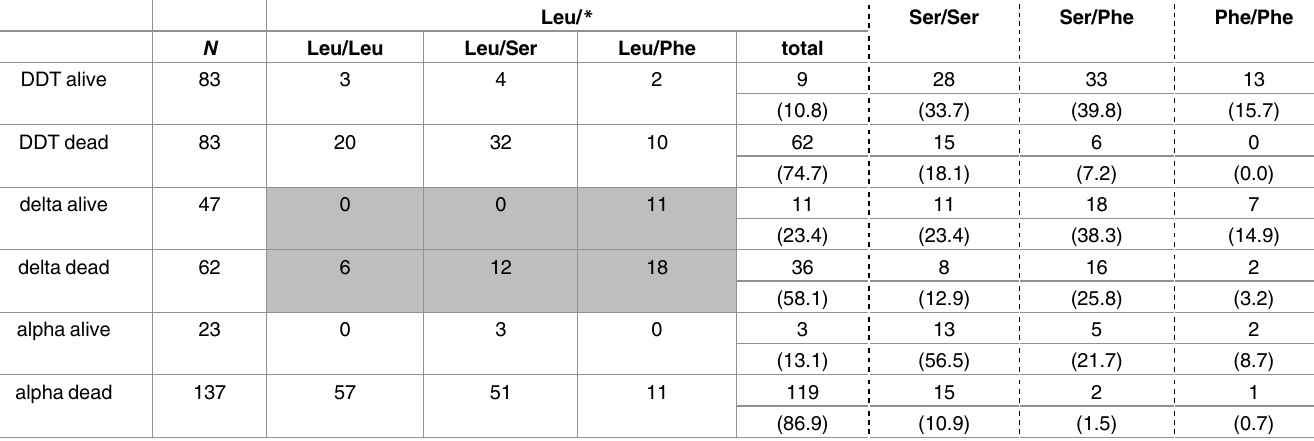
Table 2. Genotype frequencies at Vgsc -1014and their relationship with insecticide